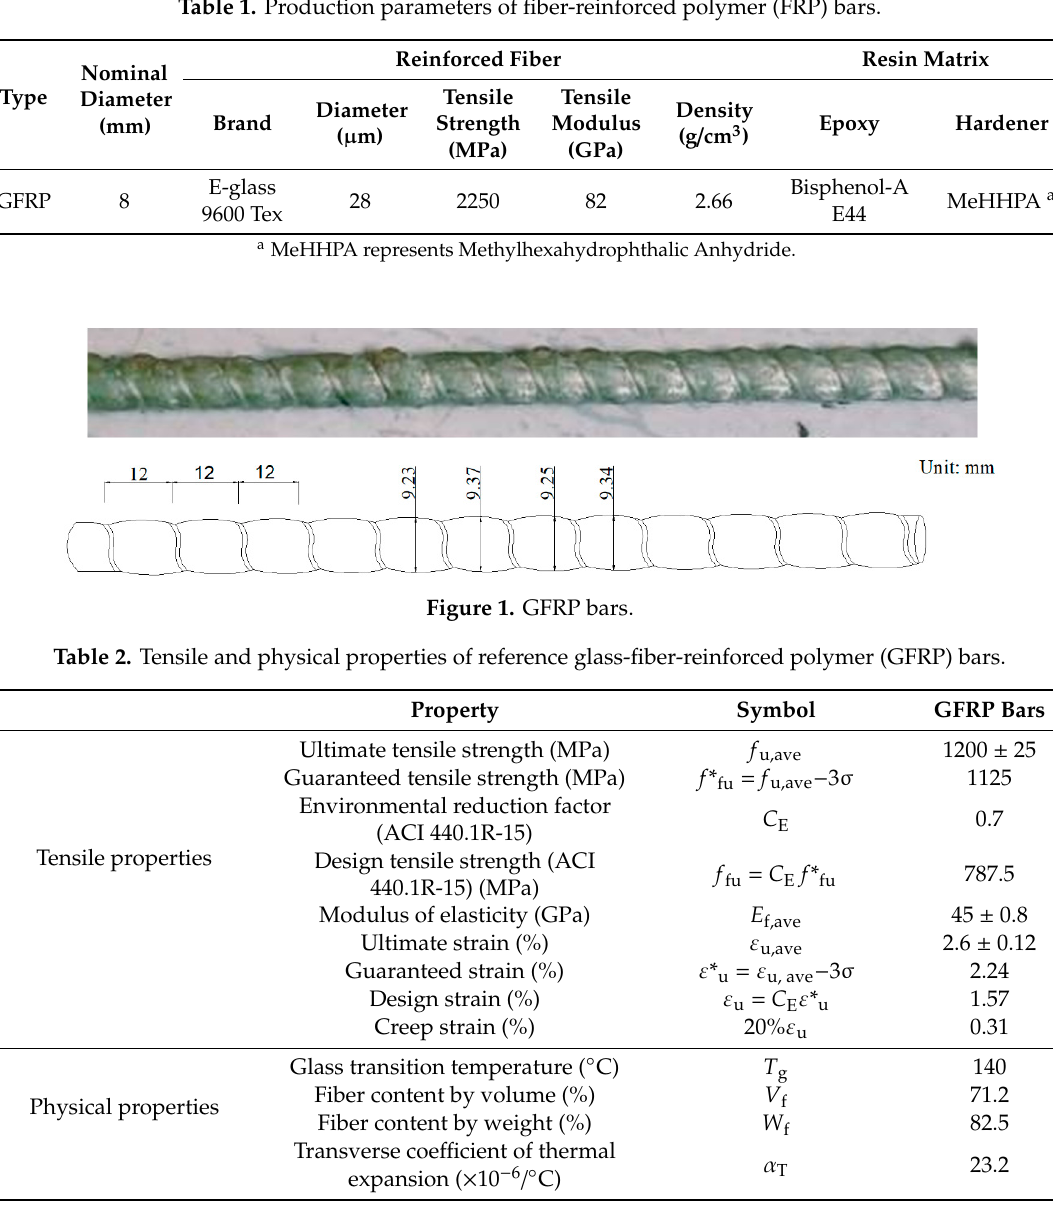
Table 1. Production parameters of fiber-reinforced polymer (FRP) bars.